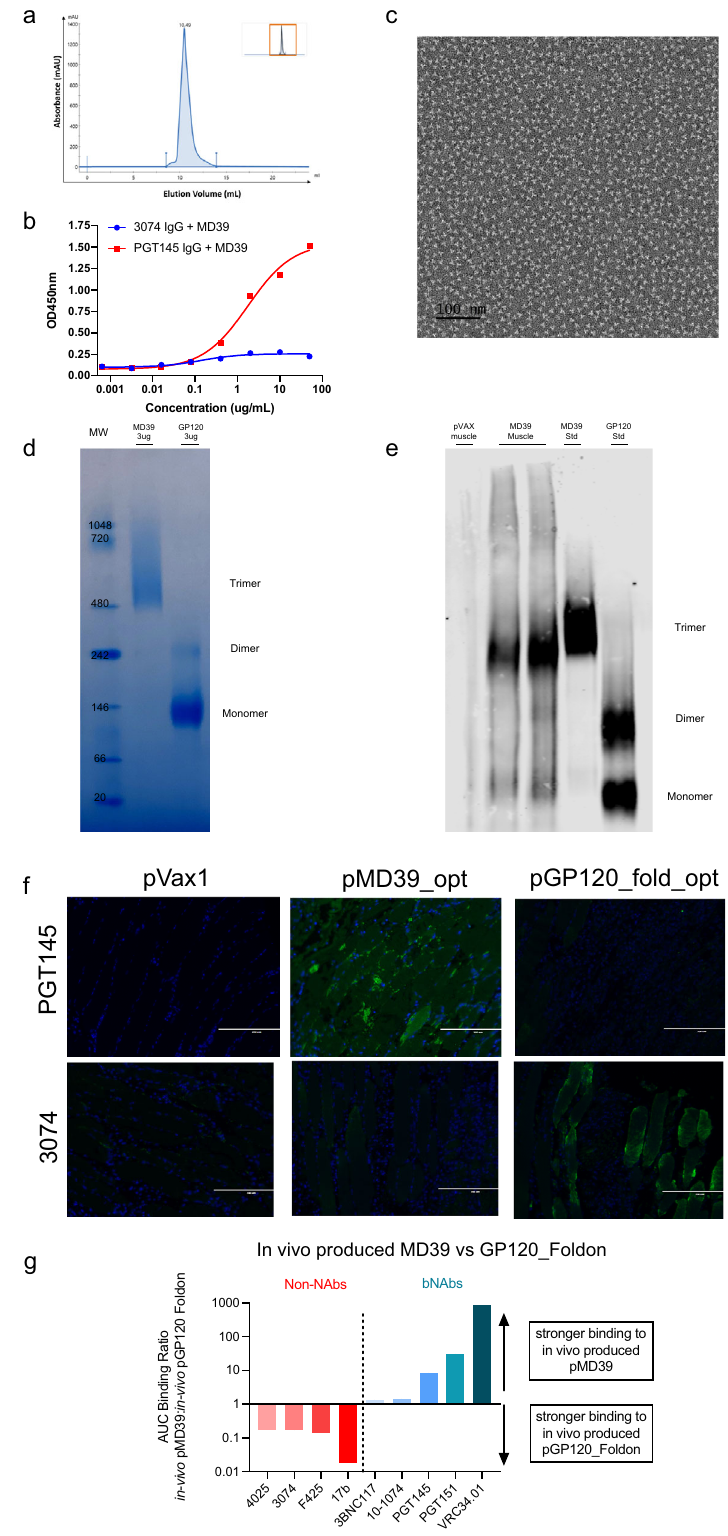
with domain-wise global folding pathways of newly synthesized polypeptides 38 (Fig. 1e). Differences in vivo produced versus recombinantly produced BG505.MD39 may re fl ect differences in glycosylation pro fi les between Exp293F cell line versus murine muscle cell-produced glycoproteins. To further assess the antigenic pro fi le including glycan-sensitive antibodies of in vivo